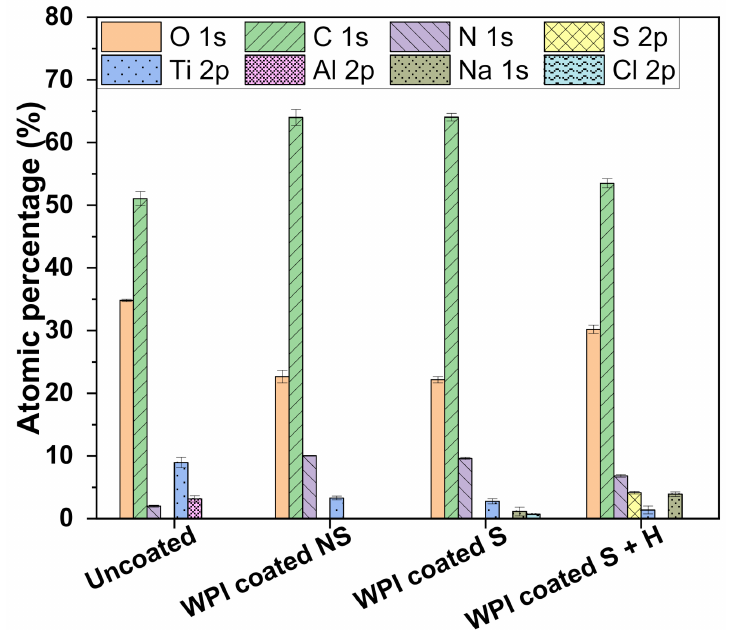
Figure 4. Atomic composition of uncoated and coated Ti6Al4V samples measured by XPS. Error bars represent the standard deviation.